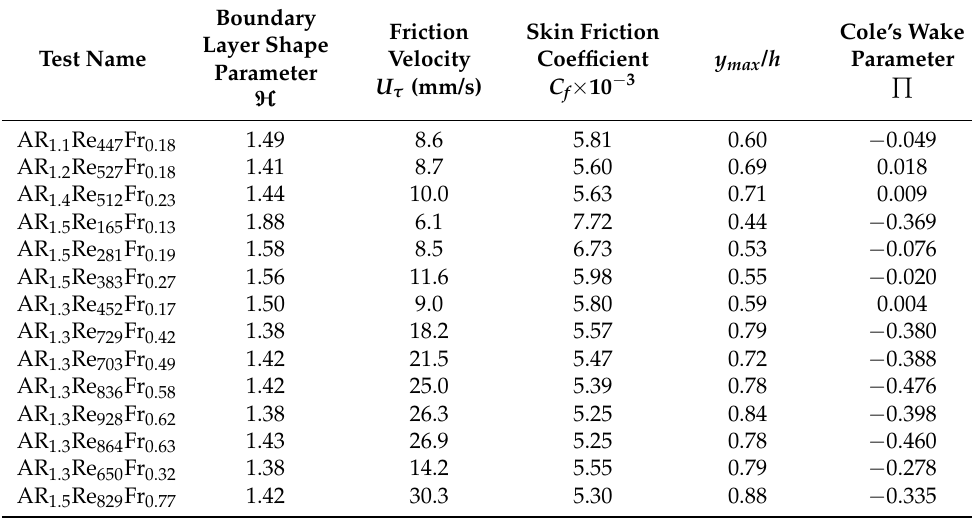
Table 2. Summary of mean flow parameters. Table 1. Summary of test conditions and relevant boundary layer